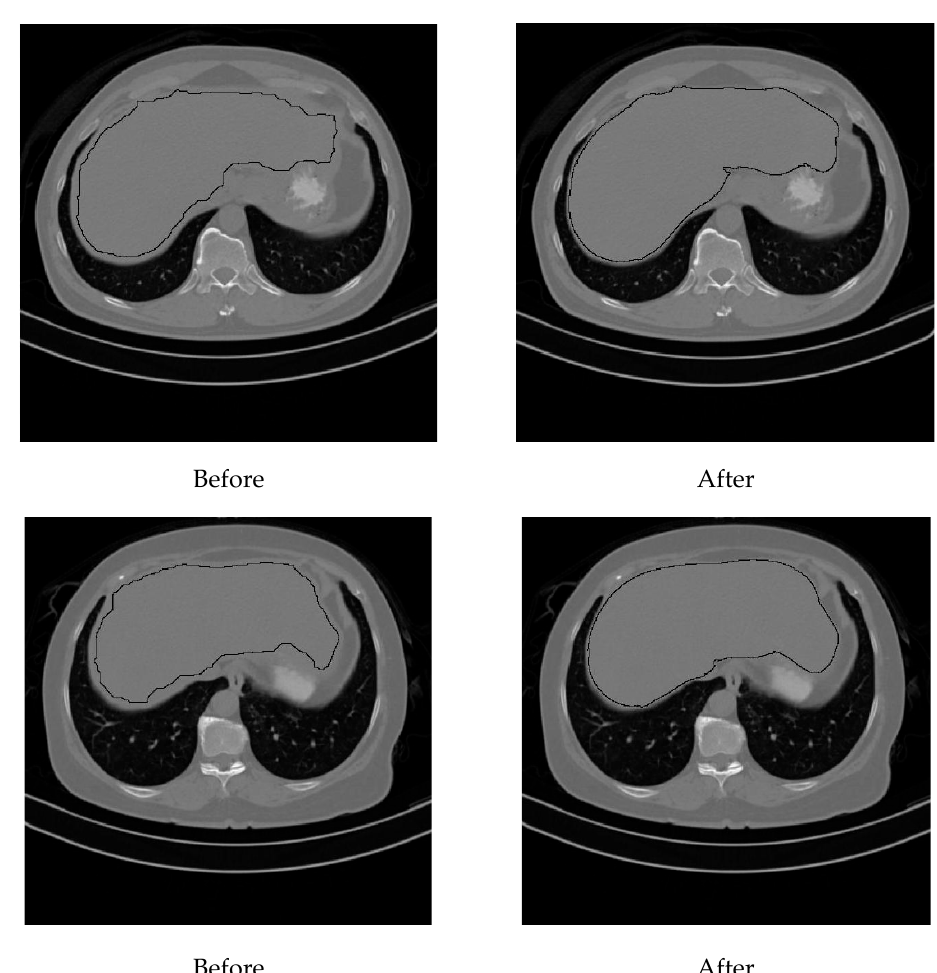
Figure 6. Final liver segmentation in the starting slices.